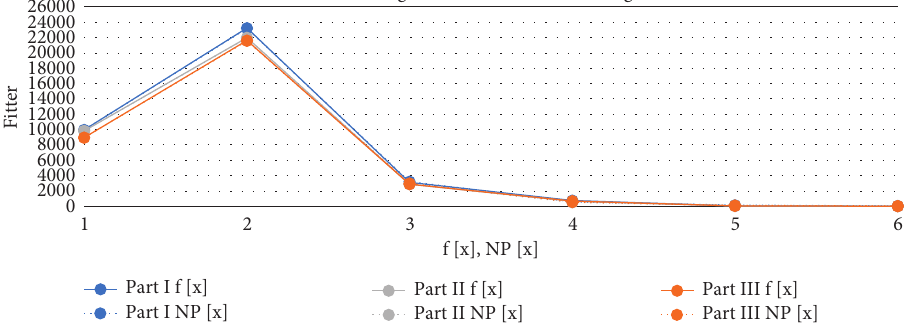
Figure 2: Fitting extended logarithmic to static word-length distribution data of the three parts of DRC. Table 5: Using the Altmann-Fitter to fit the dynamic word-length distribution data of the three parts of DRC. Part I Part II DM